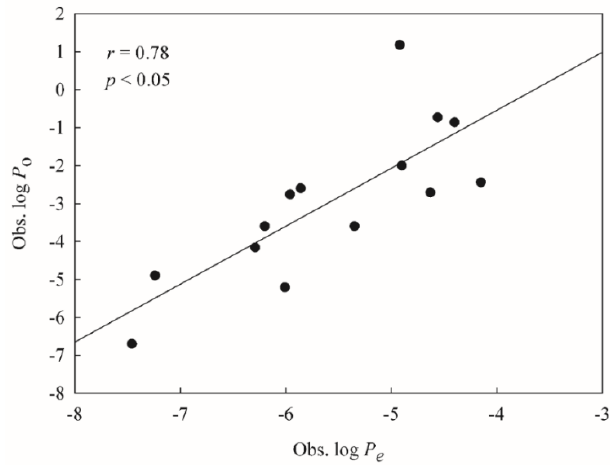
Figure 7. The observed log of the intrinsic permeability coefficient ( P o ) values vs. the observed log P e values.